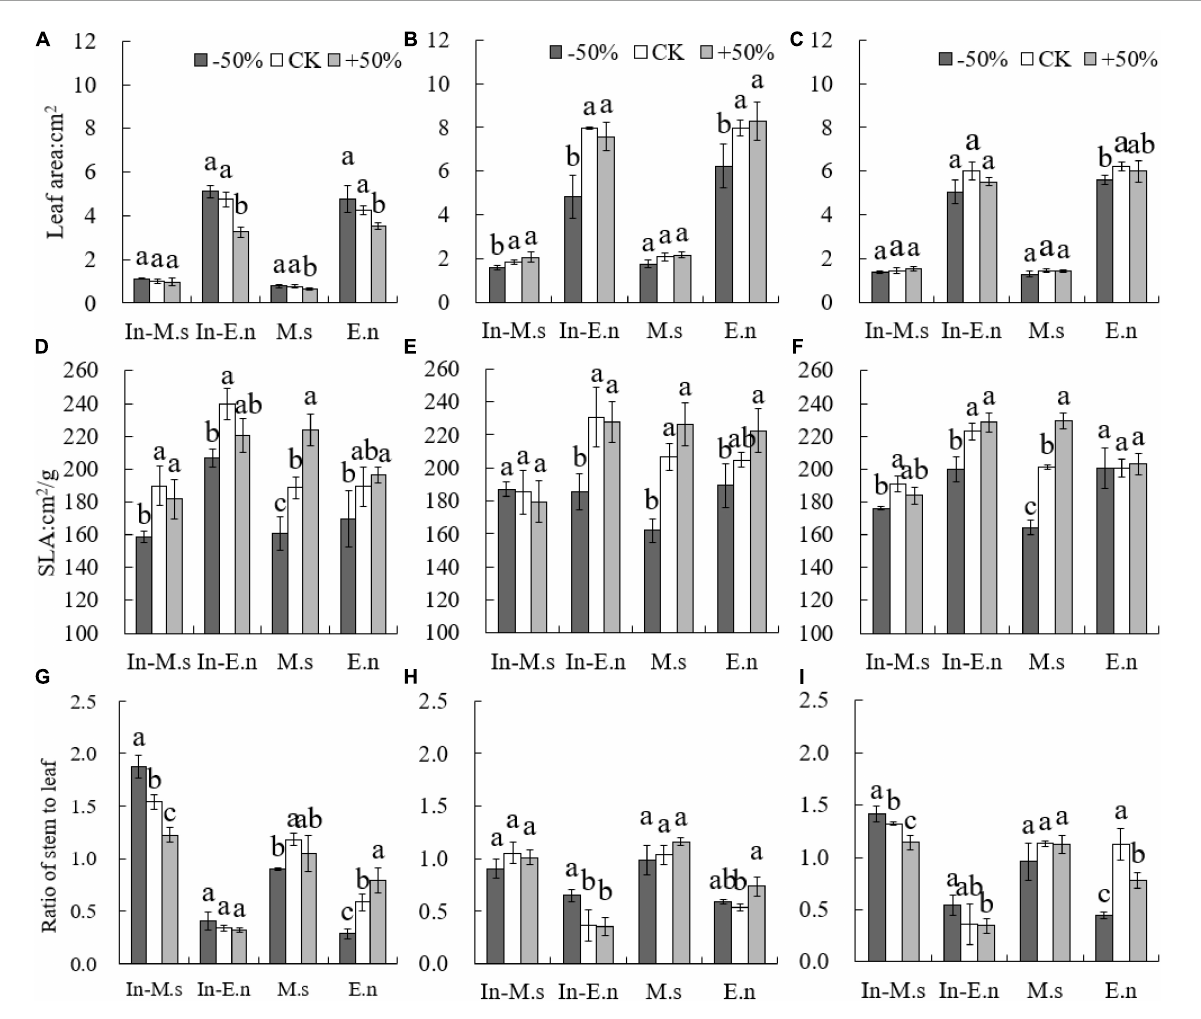
FIGURE9 Differences in forage traits under different water conditions ( A,D,G : 2015; B,E,H : 2016; C,F,I : 2017). Different lowercase letters show significant differences under different water levels ( P <